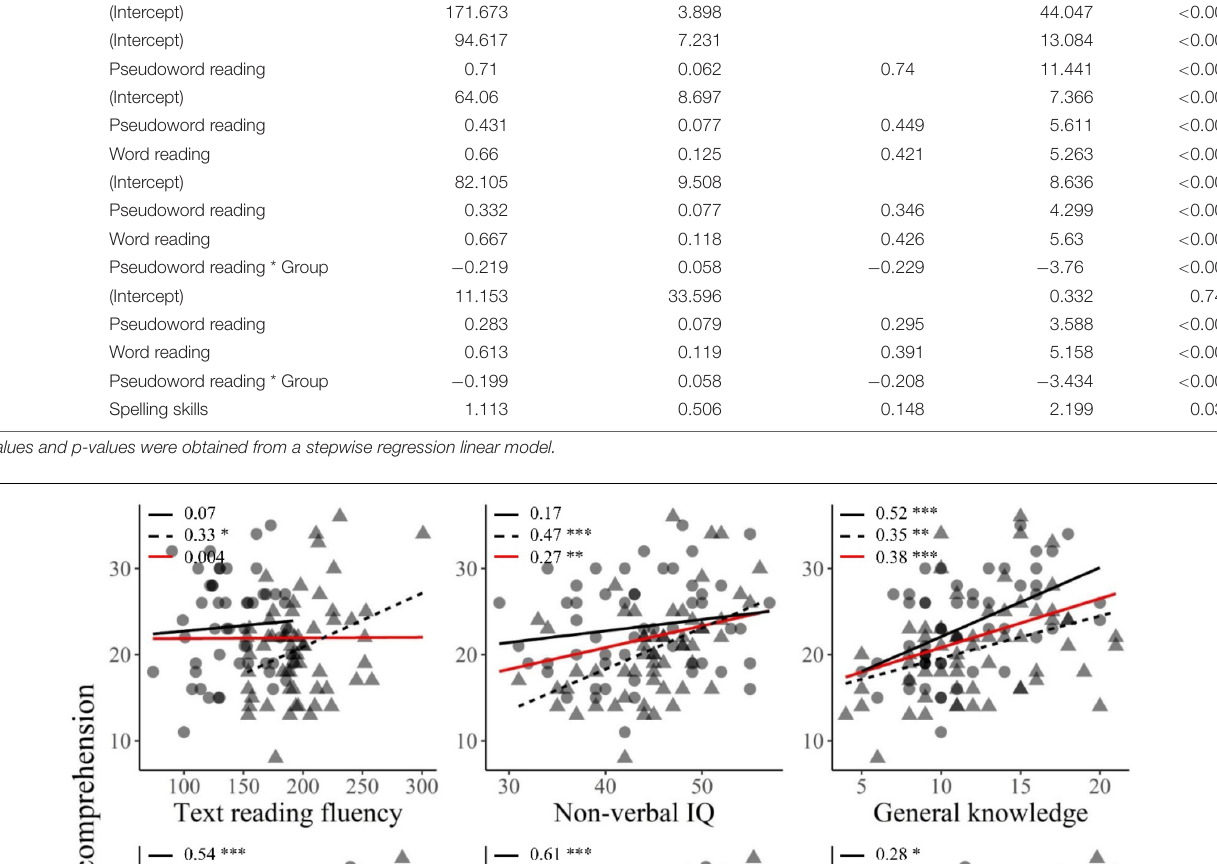
TABLE 3 | Regression coefficients of the model.